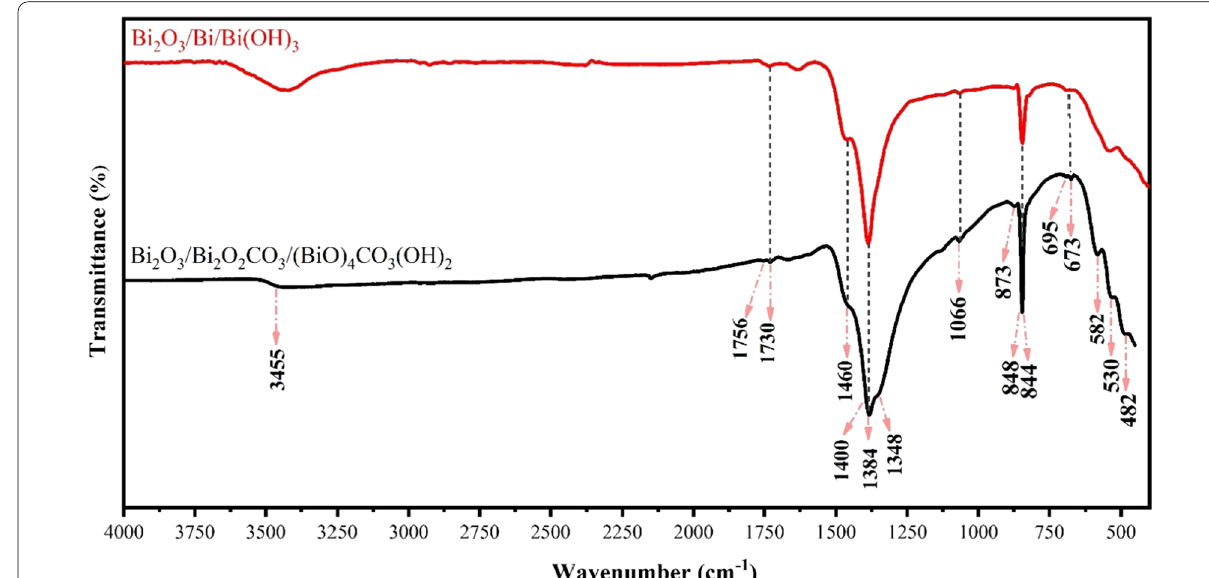
Fig. 1 FT-IR spectra of synthesized nanostructures by electrical arc discharge